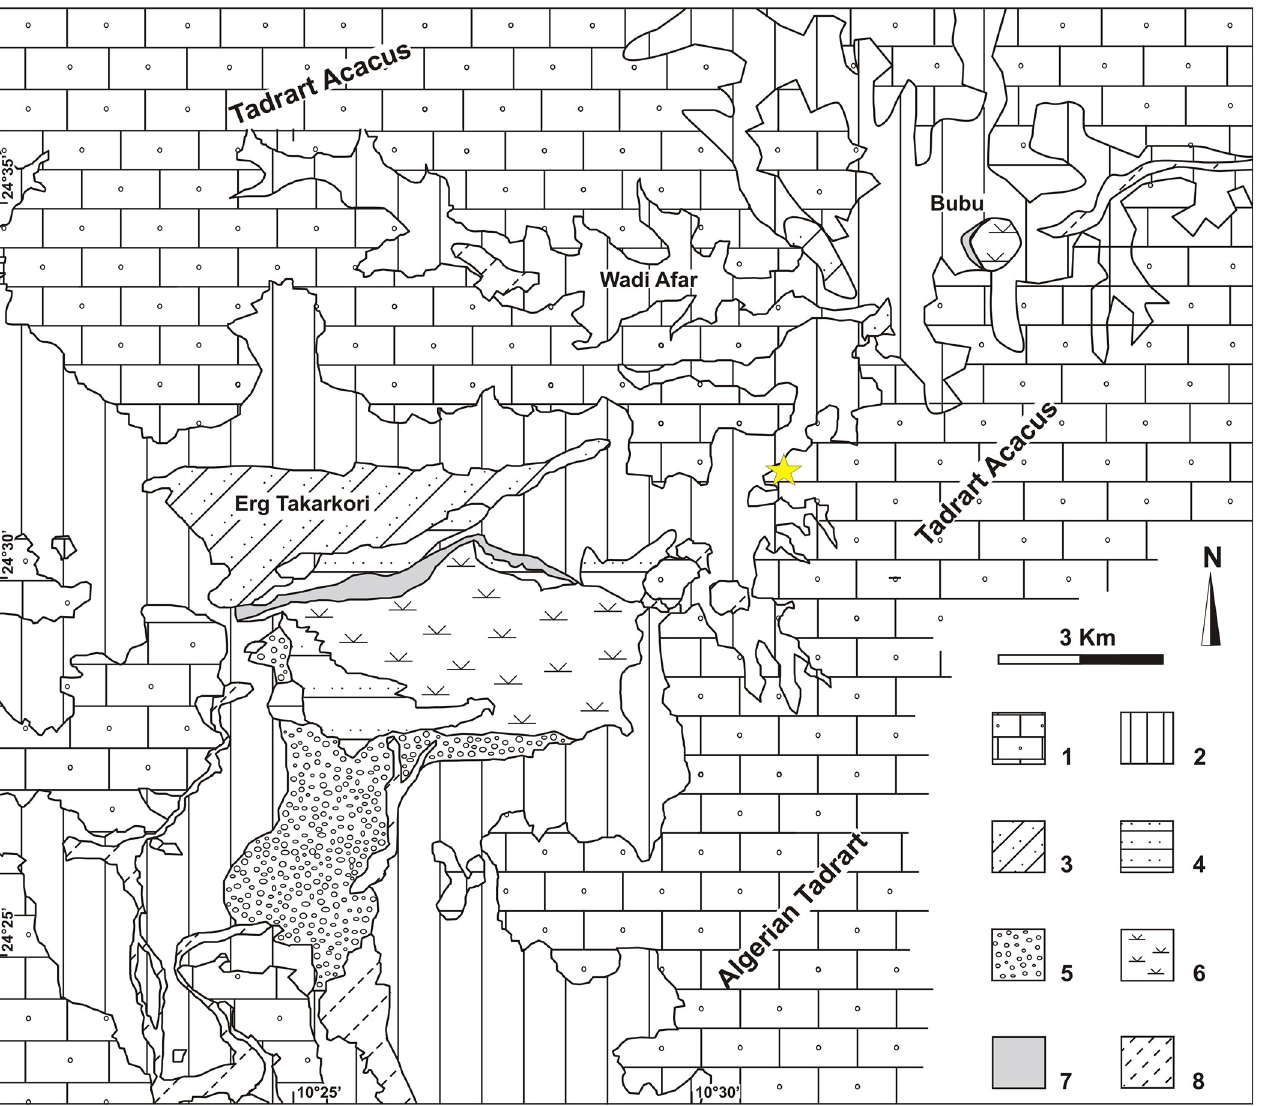
Fig 2. Geomorphological map of the Takarkori region (modified from Cremaschi et al., 2014); the star indicates the position of the rock shelter. Key: 1) bedrock (sandstone and siltstone, Paleozoic); 2) pediment and slope deposits (Neogene/Quaternary); 3) red dunes (Pleistocene); 4) yellow dunes (Holocene); 5) fluvial gravel (Holocene); 6) lake sediments (Early/Middle Holocene); 7) organic shore deposits (Early/Middle Holocene); 8) recent alluvium (Late